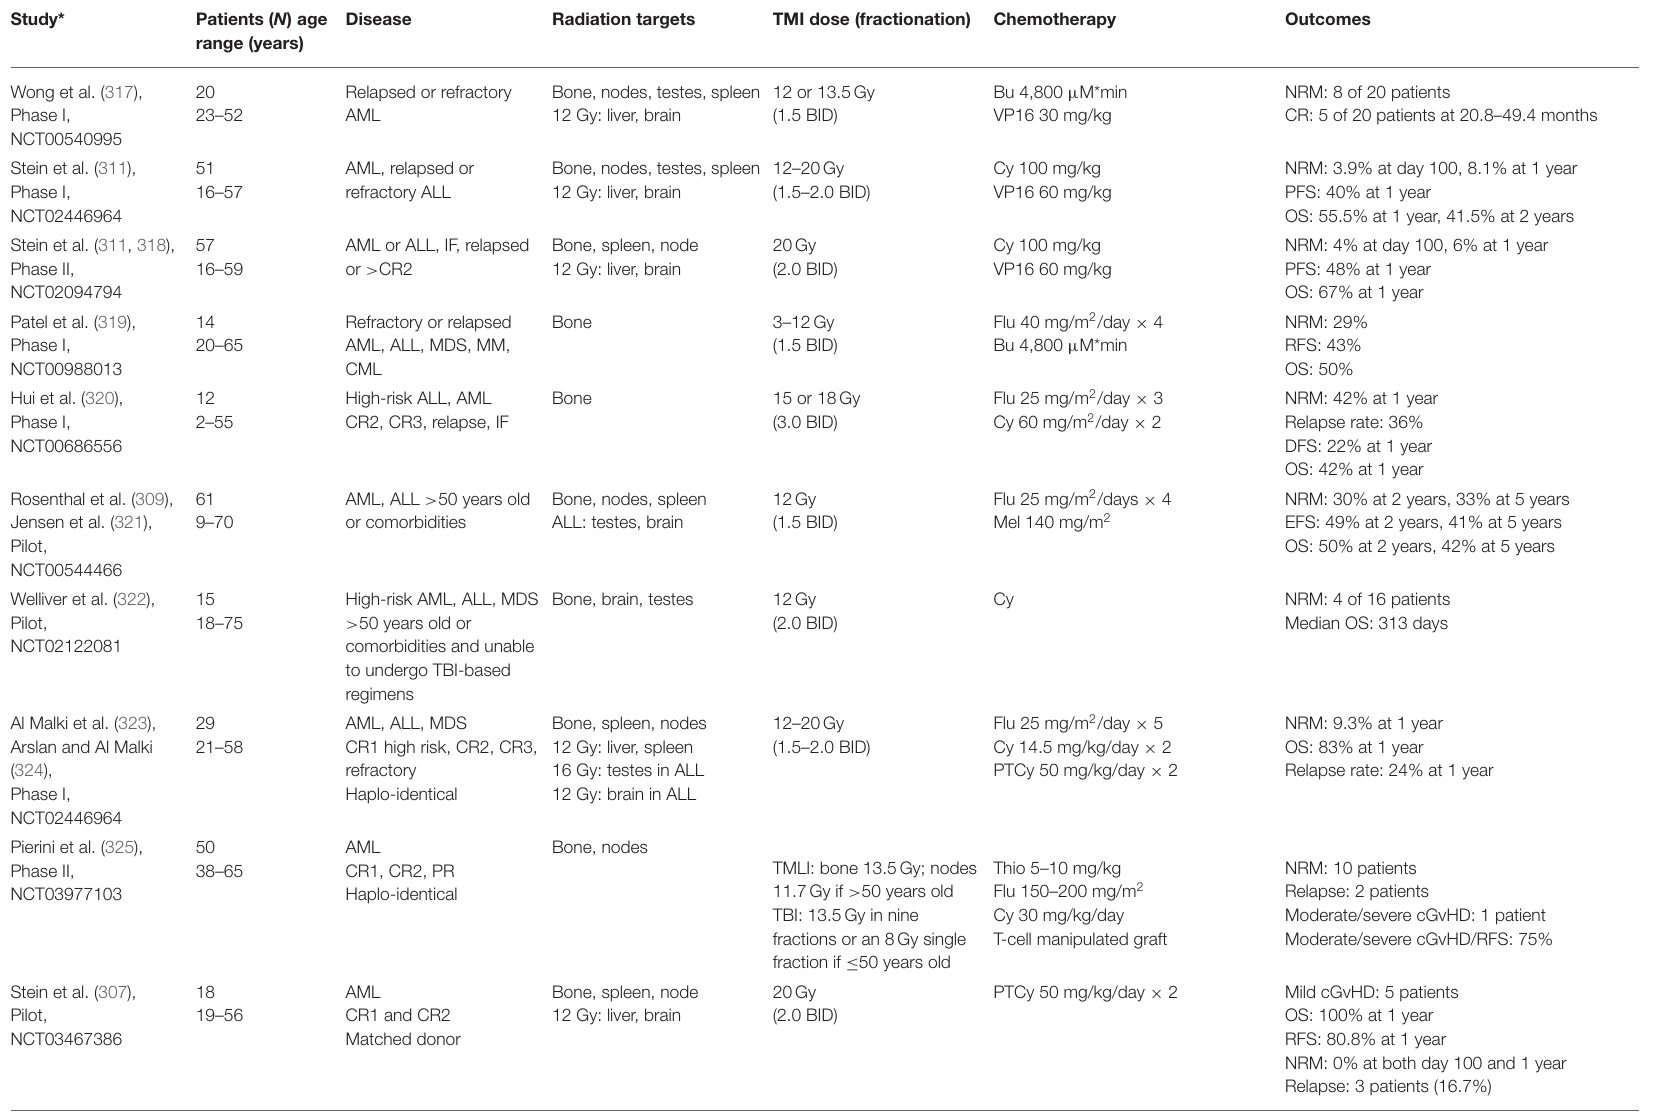
TABLE 3 | TMI and TMLI Trials in Patients with Acute